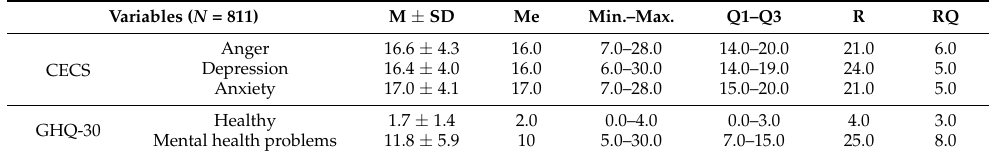
Table 3. Analysis of the general health of nursing personnel according to the General Health Questionnaire GHQ-30 and subjective emotional control according to CECS. Variables ( N = 811) M ±